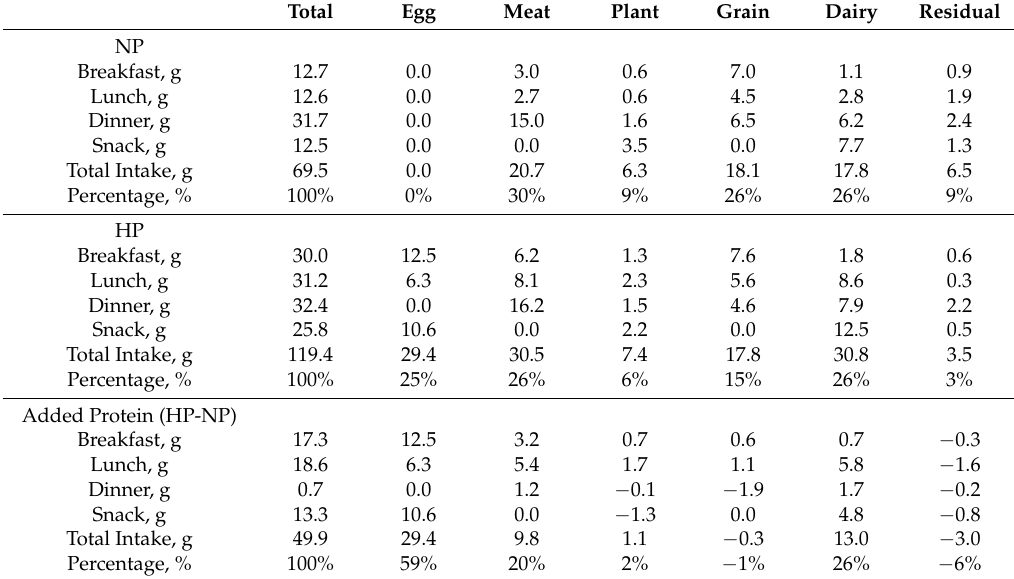
Table 1. Average daily protein intake and source distribution for a representative 85 kg adult participant 1 . Total